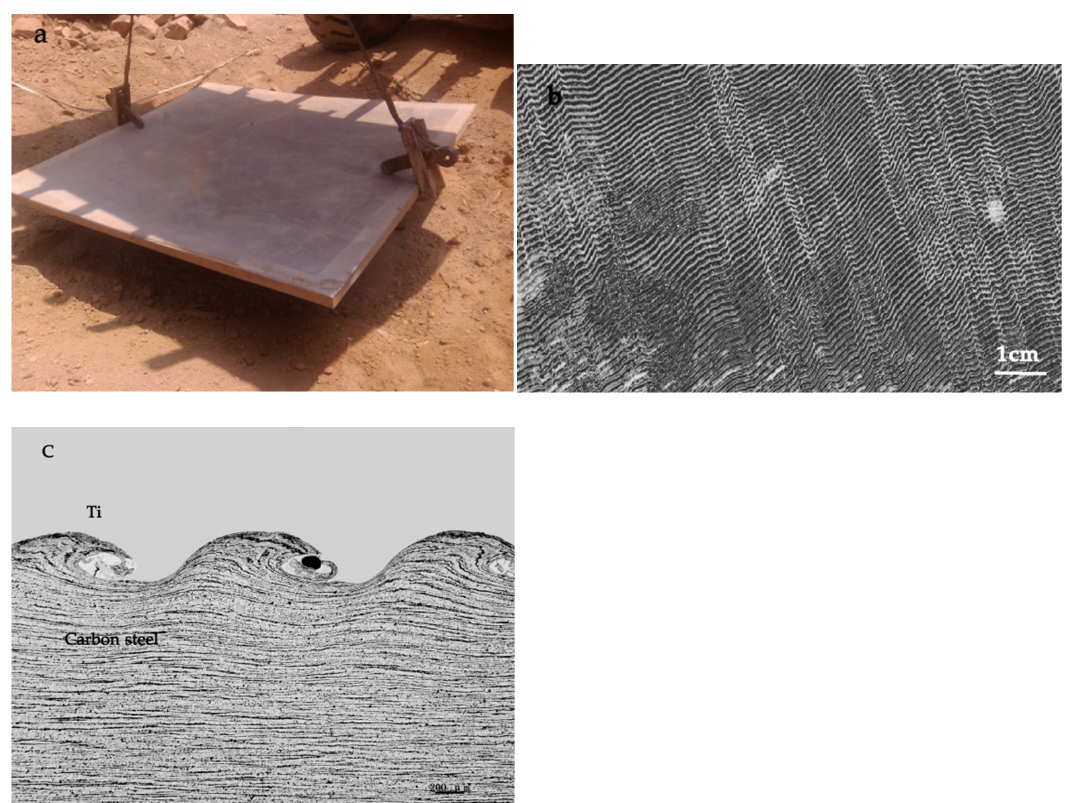
Figure 2. The clad plate after explosive welding: ( a ) appearance of the Ti-carbon steel clad plate; ( b ) the bonding interface image of the clad plate observed using the ultrasonic C-scanning; ( c ). the optical microstructure of the clad plate interface